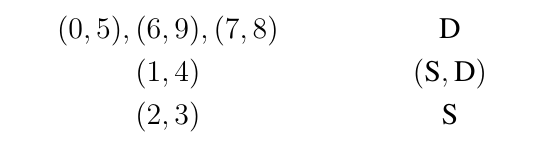
Table 6. Player’s optimal move under Model B3, indicated by D (draw), S (stand), or ( S , D ) p , draw with probability p ). Here p is as in Equation (stand with probability 1